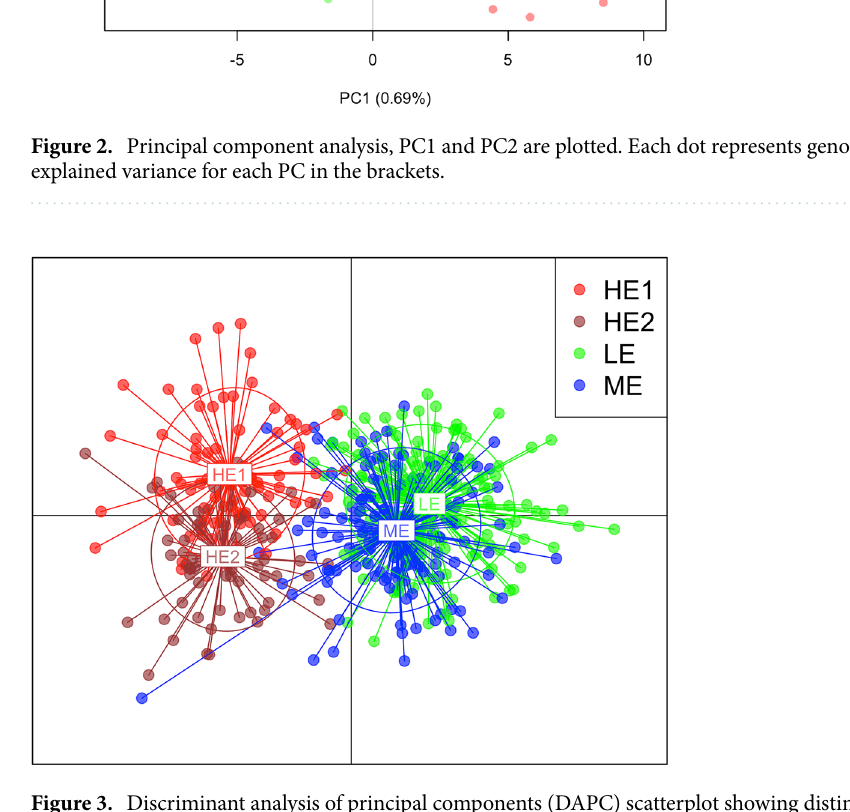
Figure 3. Discriminant analysis of principal components (DAPC) scatterplot showing distinctiveness of the high-elevation (both HE1 and HE2 groups) ecotype in relation to the LE and